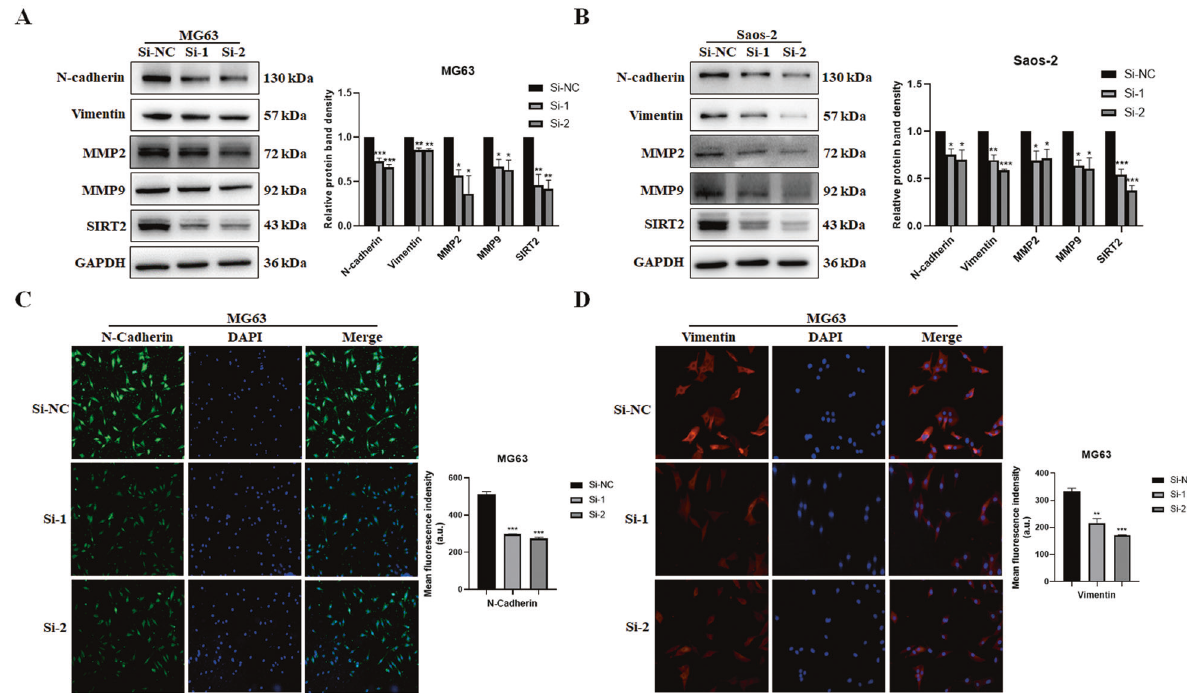
Fig. 3 SIRT2 knockdown downregulates the expression of mesenchymal proteins. A , B The expression of EMT-related proteins was detected by Western blot after SIRT2 knockdown in MG63 and Saos-2 cells. Results from three experiments are summarized in a histogram format. C , D Representative immuno fl uorescence of N-cadherin and Vimentin after SIRT2 knockdown was shown. The right panel was the summarized data of immuno fl uorescence score of N-cadherin and Vimentin expression density. (* P < 0.05, ** P < 0.01, *** P <